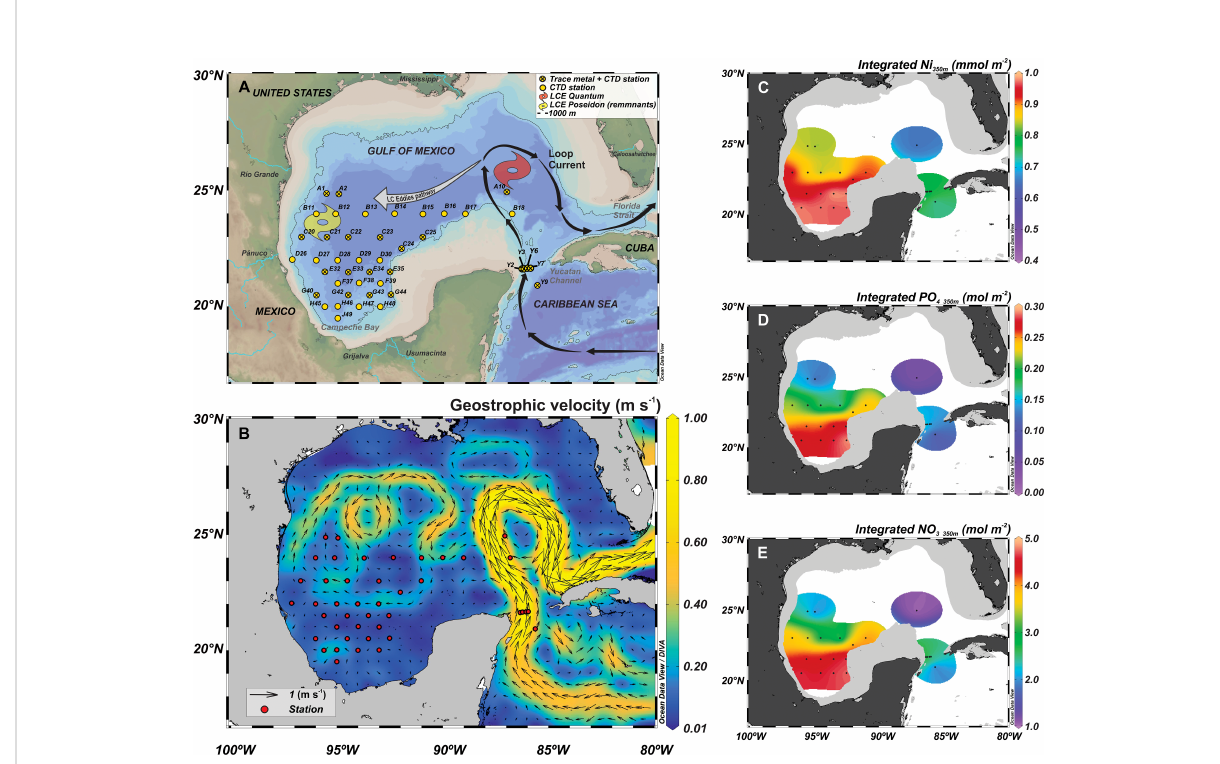
FIGURE 1 (A) Map of the Gulf of Mexico and sampling stations during the XIXIMI-6 cruise carried out in the summer of 2017 (August 19 to September 8). (B) Mean satellite-derived geostrophic velocity fi eld during the cruise period. Mapping of the integrated concentration of (C) dissolved Ni, (D) phosphate (PO 4 ) and (E) nitrate plus nitrite (NO 3 ) in the fi rst 350 m of the water column during the XIXIMI-6 cruise. The big gray arrow shown in panel (A) indicates the typical pathway and transport direction of the loop current eddies (LCE). The location of hydrographic sampling stations where the CTD casts were made are indicated by yellow and red circles in panels (A, B) , respectively. Water samples for dissolved Ni and macronutrient analysis were also collected at stations with crossed yellow circles. This fi gure was made using Ocean Data View (Schlitzer,